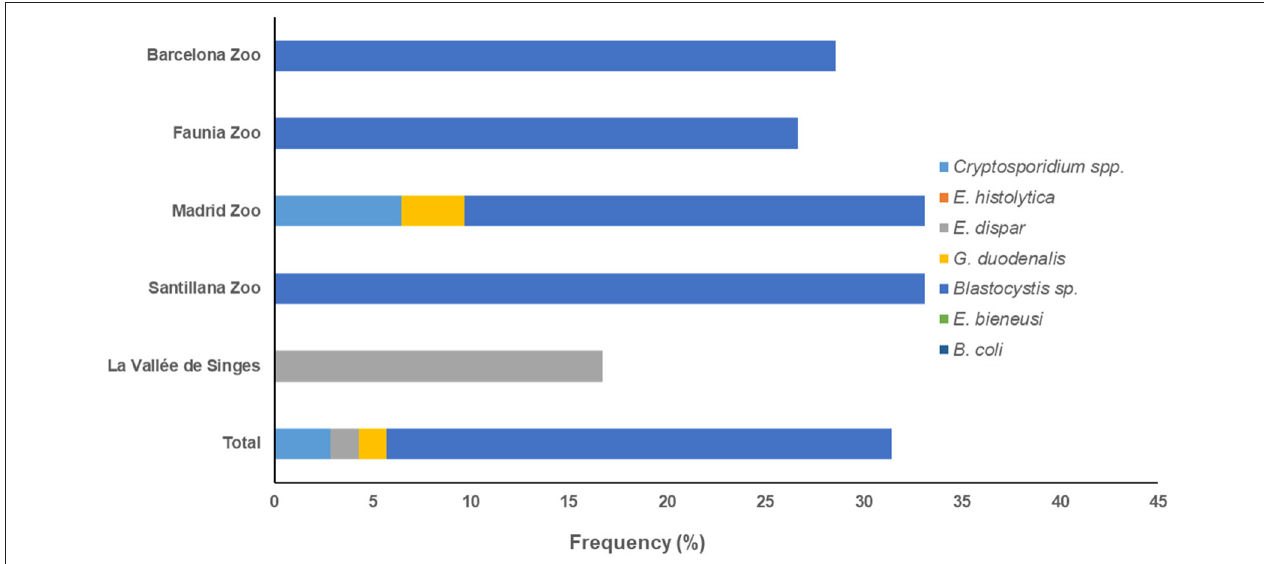
FIGURE 2 | Accumulated frequencies of enteric protist species detected in humans by participating institution in the present